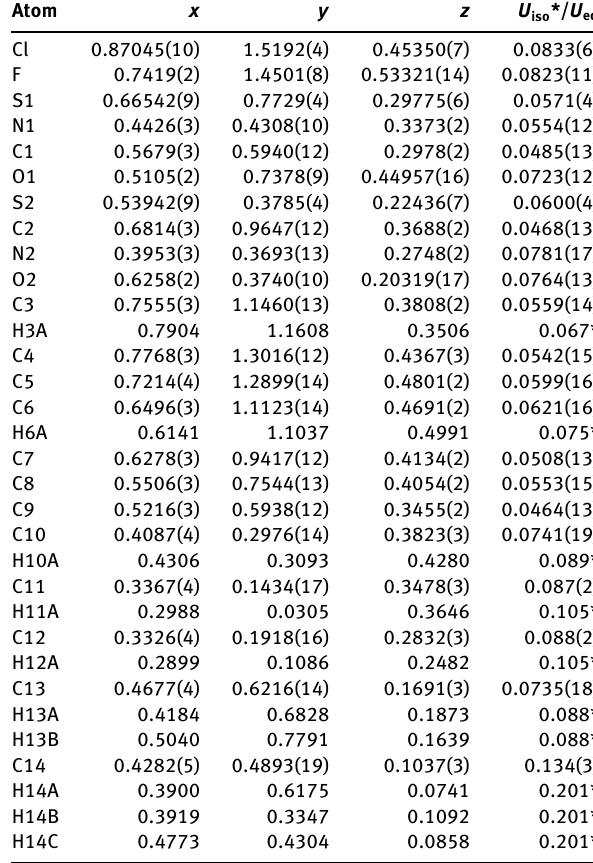
Table 2: Fractional atomic coordinates and isotropic or equivalent isotropic displacement parameters (Å 2